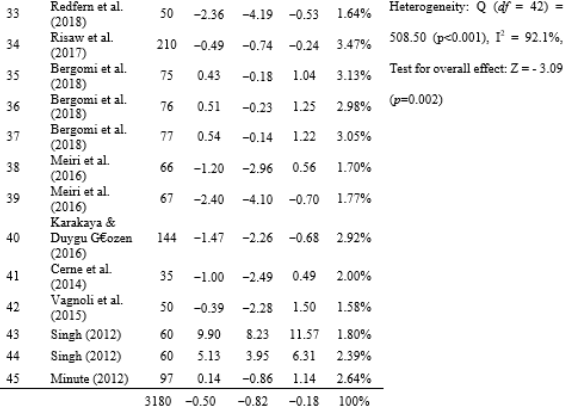
Figure 2. The effect of distract intervention on needle-related pain of the child. ES: Effect size, CI = Confidence interval.